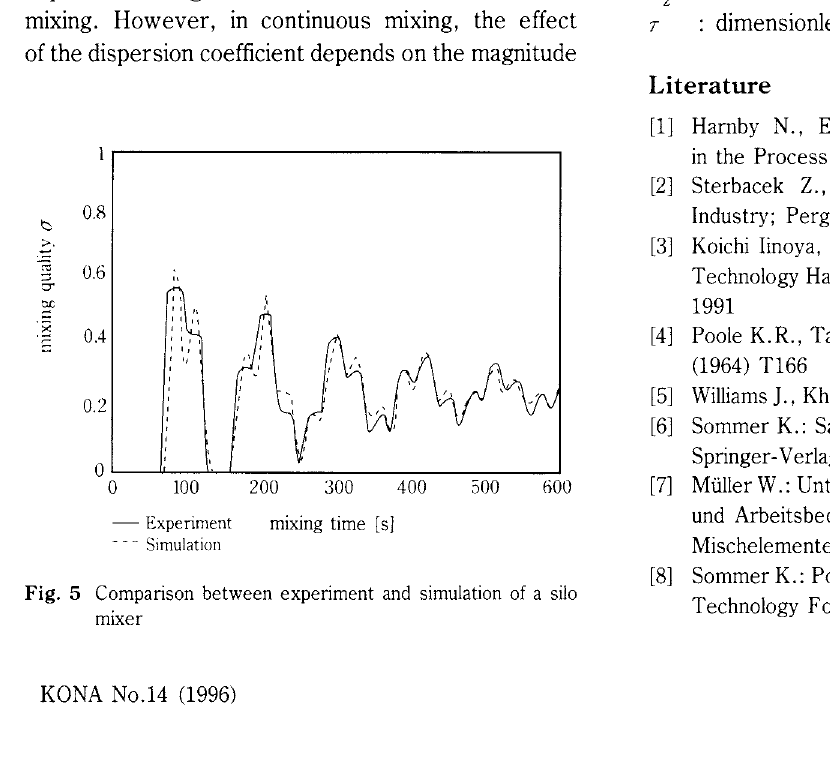
Fig. 5 Comparison between experiment and simulation of a silo